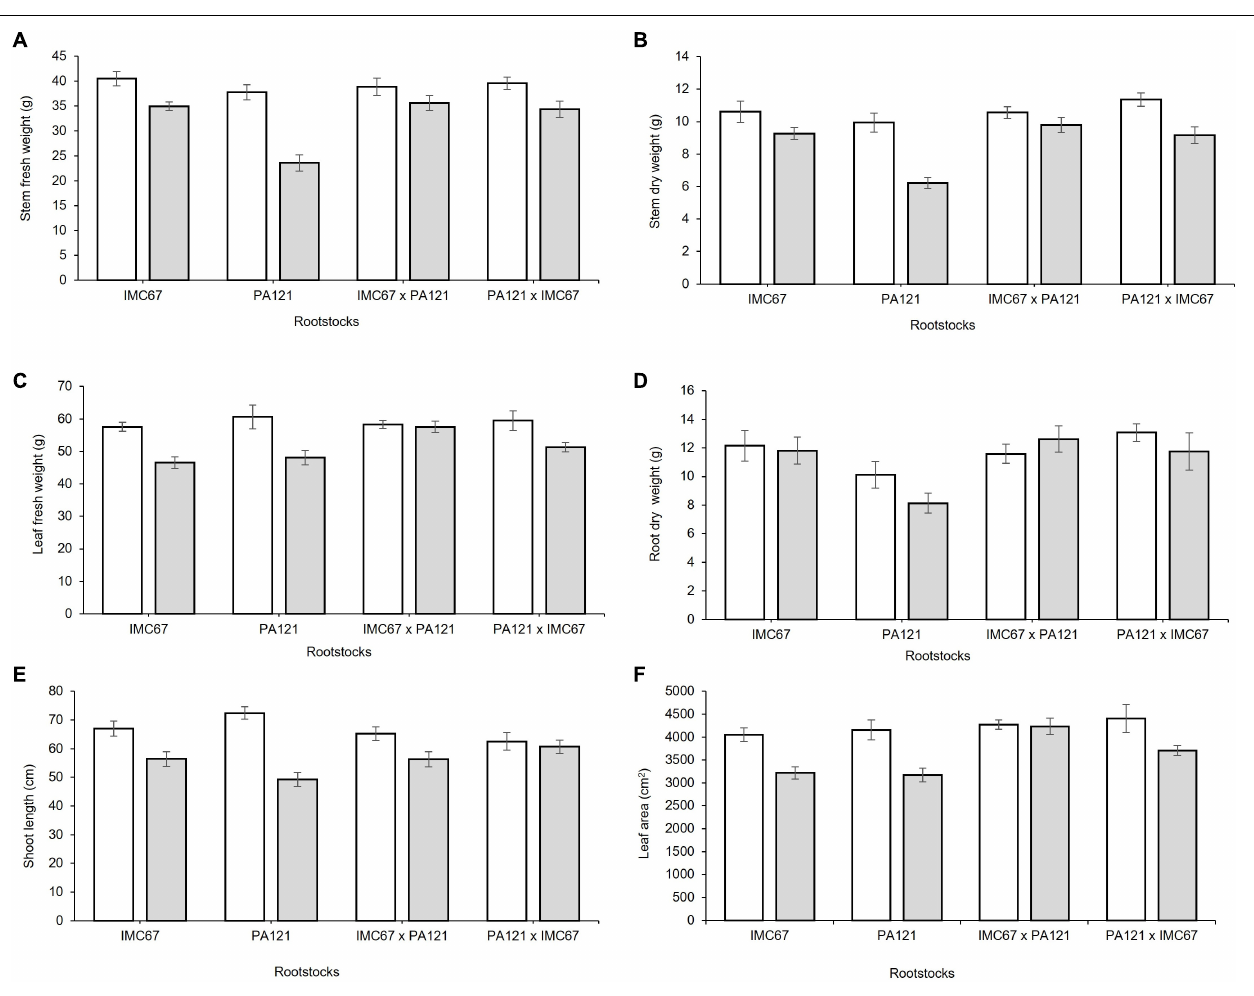
FIGURE 4 | Plant growth of four families of ungrafted seedlings under greenhouse conditions at two different concentrations of Cd in soil, 5 months after cadmium treatment. (A) Stem fresh weight, (B) stem dry weight, (C) leaf fresh weight, (D) root dry weight, (E) shoot length, and (F) leaf area. White bars represent rootstocks grown in soil without addition of Cd (0.43 mg kg − 1 ). Gray bars represent rootstocks grown in Cd spiked soil (7.49 mg kg − 1 ). Data are mean values ± SE ( n =